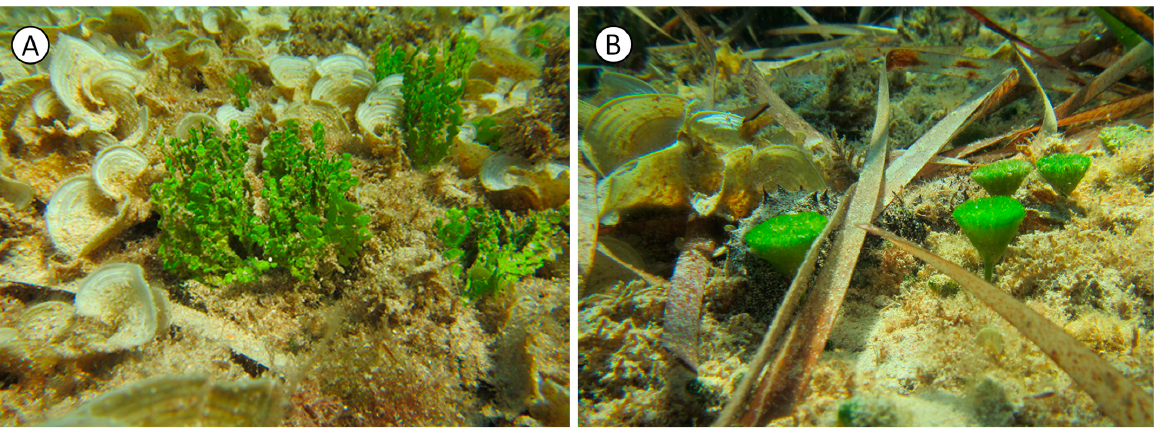
Figure 1. Representative images of the invasive algae Halimeda incrassata ( A ) and Penicillus capitatus ( B ) coexisting with Padina pavonica .